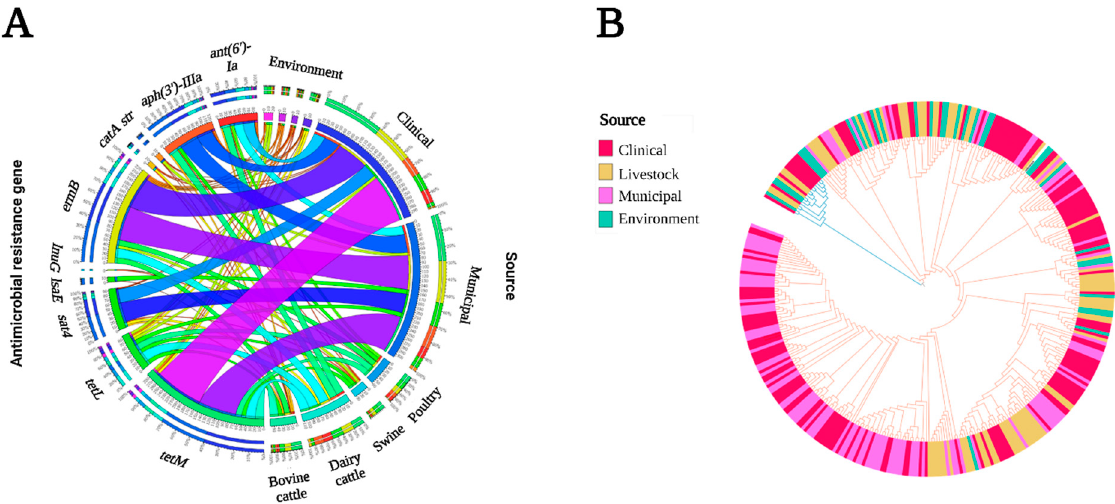
Figure 4. Comparative genomic analysis of 376 genomes E. faecalis genomes across the One Health continuum. ( A ) Circos plot depicts the relationship between commonly found ARGs and One Health sectors. The variables (ARGs and genome isolation source) are arranged around the circle and distinguished by different colors. The percentage of ARGs across various sectors is indicated by proportional bars (http://circos.ca/). ( B ) Maximum likelihood core-genome phylogenetic tree. E. faecalis ATCC 47077/OG1RF (CP002621.1) was used as the reference genome. Genomes were char-